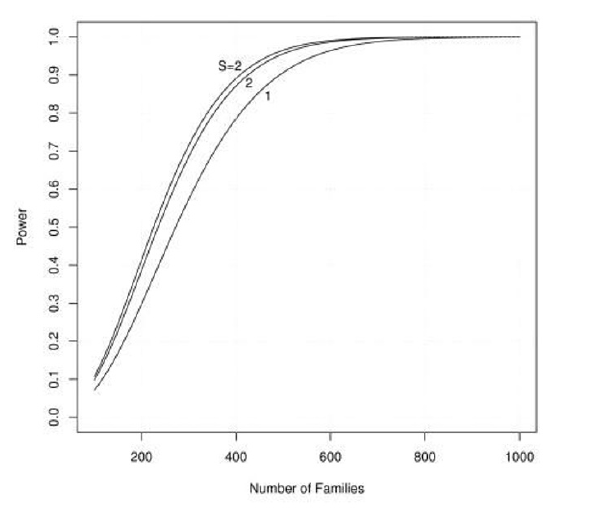
Effect of varying number of offspring proxies on power for families of two affected siblings . Effect of sample size and varying numbers of offspring proxies (1 or 2) on estimated power, families with two affected sibs, with only one available for genotyping (1 or 2), compared with families with both affected sibs available for genotyping (S =